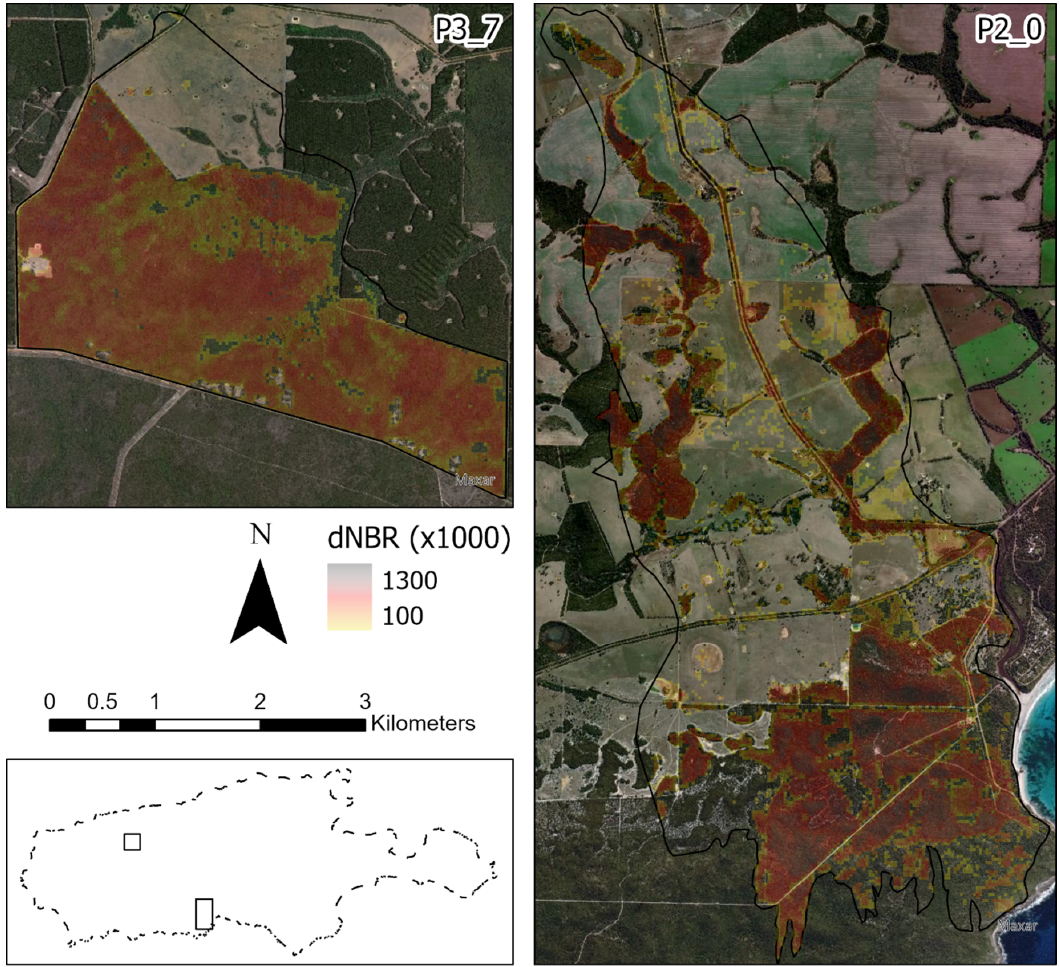
Figure A3. Closer view of two select fires (P3_7, P2_0), with dNBR set to 75% transparency. P3_7 burned in February 2001 at the northern edge of Flinders Chase NP. P2_0 burned in December 1994 just west of Vivonne Bay. In both cases (and for other fires that burn in these types of landscapes), dNBR values above 100 almost exclusively occur in treed and dense shrubby land cover. Grasslands, agriculture and other non-woody land cover, although within the fire polygons [45] have very limited influence. Note that the ArcGIS basemap imagery over these areas are dated to 2019 (P3_7) and 2018 (P2_0) so there may have been landscape change in intervening period.